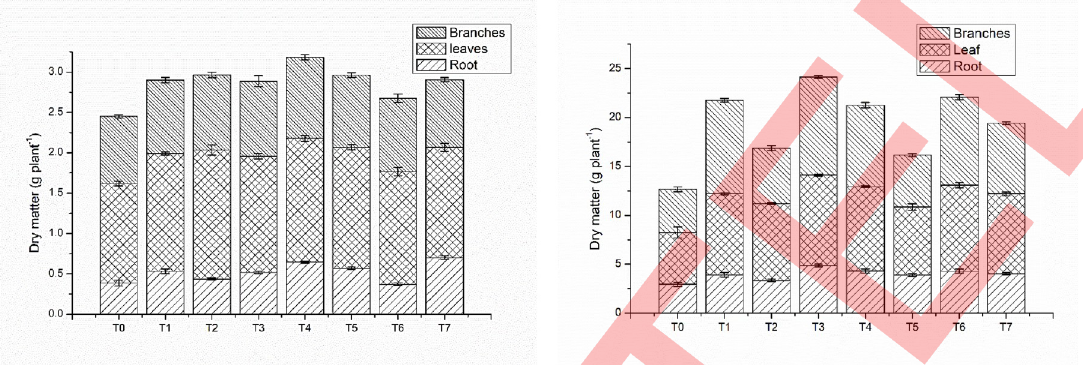
Fig 1. Effect of phosphorus levels, farmyard manure and biofertilizer on biomass accumulation at 35 DAS (a) and At harvesting (b). Bars represents error (MS).